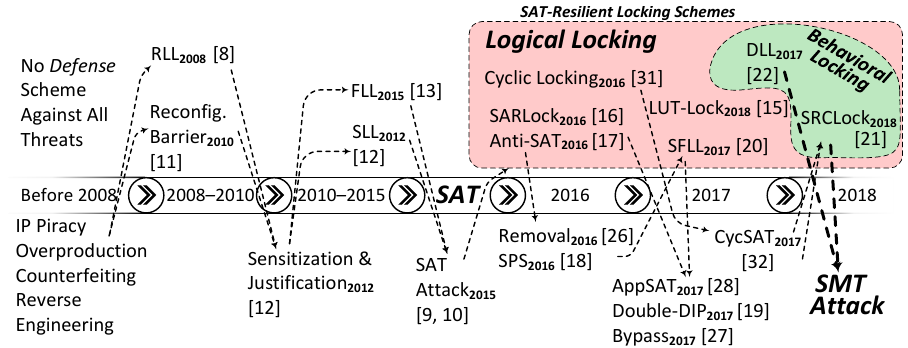
Figure 1: 10-Year History of Logic Obfuscation, the Defense Solutions, and Attack Models. The SMT attack on obfuscated circuits and study four different modes of the SMT